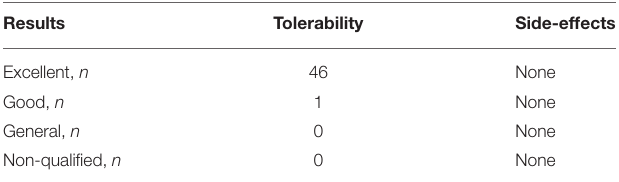
TABLE 3 | Tolerance and side effects reported by children treated with oropharyngeal probiotics ( n = 47).